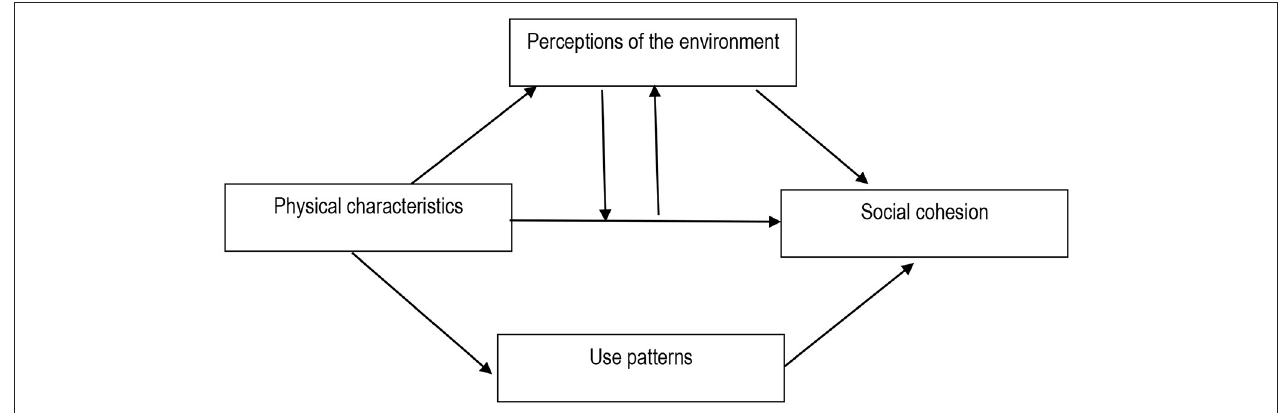
FIGURE 3 | Direct and indirect effects of aspects of green spaces on social cohesion. Source: Wan et al. (2021, p. 9).